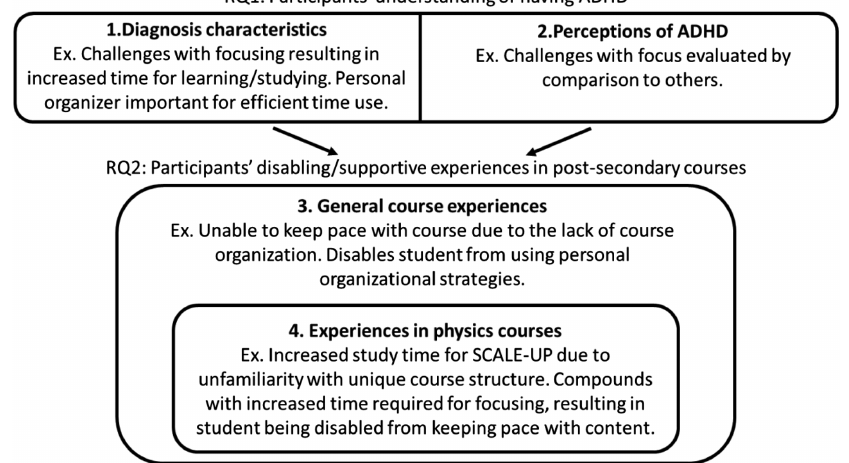
FIG. 1. Diagram showing how superordinate themes 1 and 2 give a description of participants ’ understanding of having ADHD, and how understanding ADHD influenced superordinate themes 3 and 4, which describe participants ’ experiences in postsecondary courses. This demonstrates how superordinate theme 4 includes barriers that existed throughout students ’ postsecondary experience and were increased in their physics courses. Examples from findings are included in each section to clarify connections between superordinate